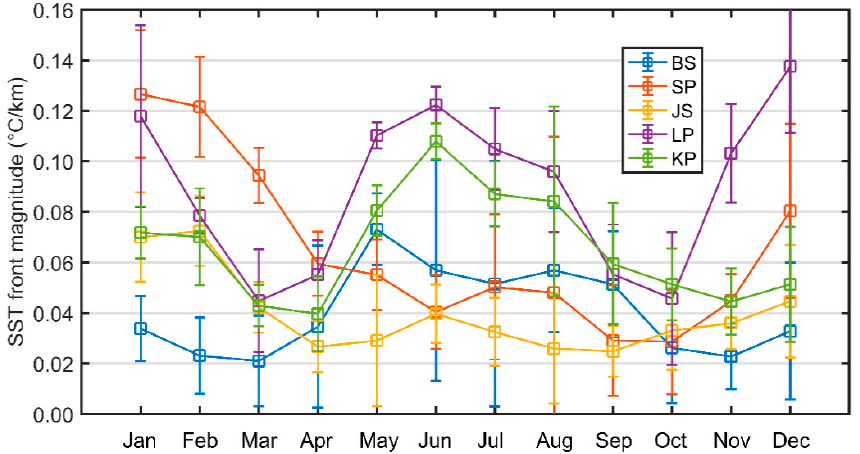
Figure 8. Monthly SST front magnitudes averaged over the five chl-a front zones (gray lines in Figure 7).